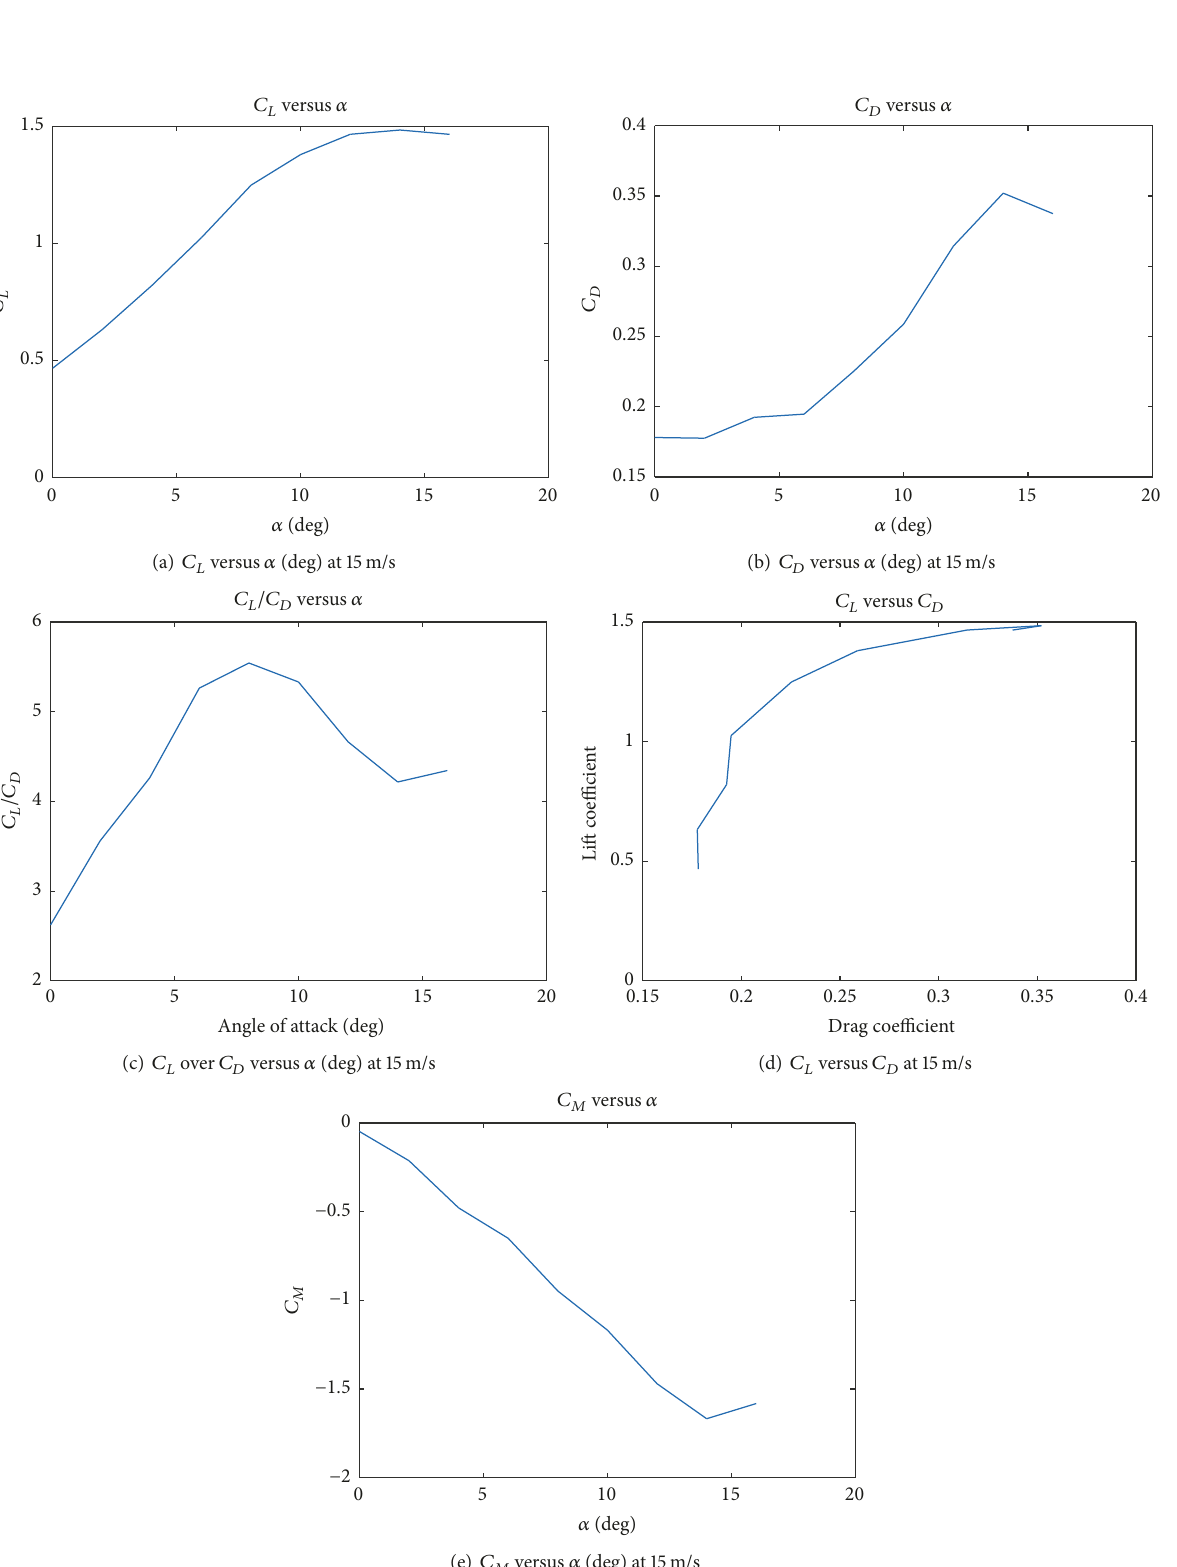
Figure 11: Aerodynamic properties of the FMW mini-UAV in 15m/s wind